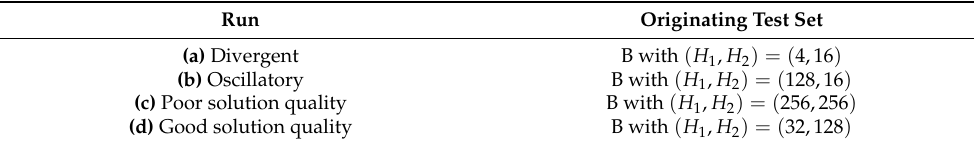
Table A3. Each run used in Section 5.2 is selected from the 10 runs in the specified test case of Table